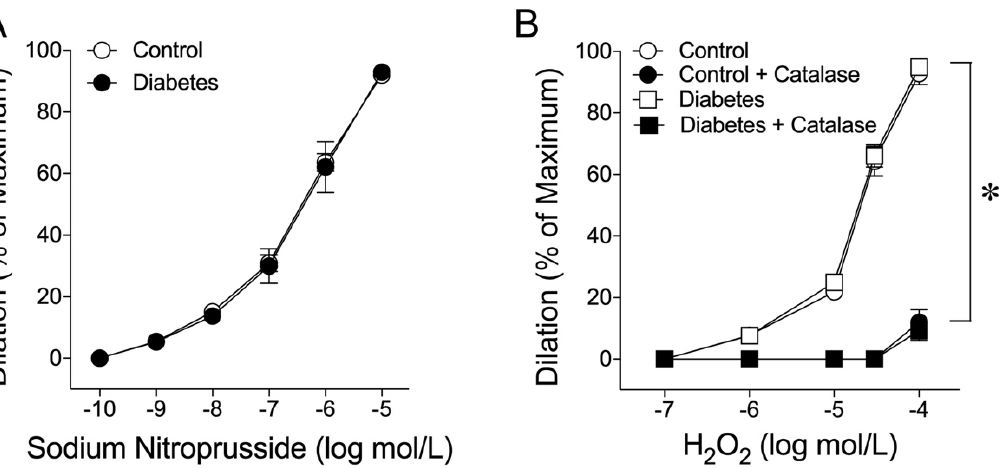
Figure 2. The role of H 2 O 2 in mediating flow- and VEGF-induced dilations was investigated in cor- onary arterioles isolated from control and diabetic pigs. ( A ): The vasodilation induced by a stepwise increase in pressure gradient ( Δ pressure), i.e., flow, in control pigs (n = 6) was not affected by H 2 O 2 scavenger catalase (1000 units/mL; n = 6). The blunted flow-induced dilation in diabetic vessels (n = 8) was further inhibited by catalase (n = 8). ( B ): The vasodilation induced by VEGF was not affected by catalase in the control pigs (n = 5). In diabetic pigs (n = 6), the vasodilation to VEGF was blunted and the remaining dilation was abolished by catalase. The resting vascular tones were not altered before and after catalase in either the control (61 ± 2% vs. 62 ± 2%) or diabetic (60 ± 2% vs. 60 ± 2%) vessels. * p < 0.05 vs. control, # p < 0.05 vs. diabetes.